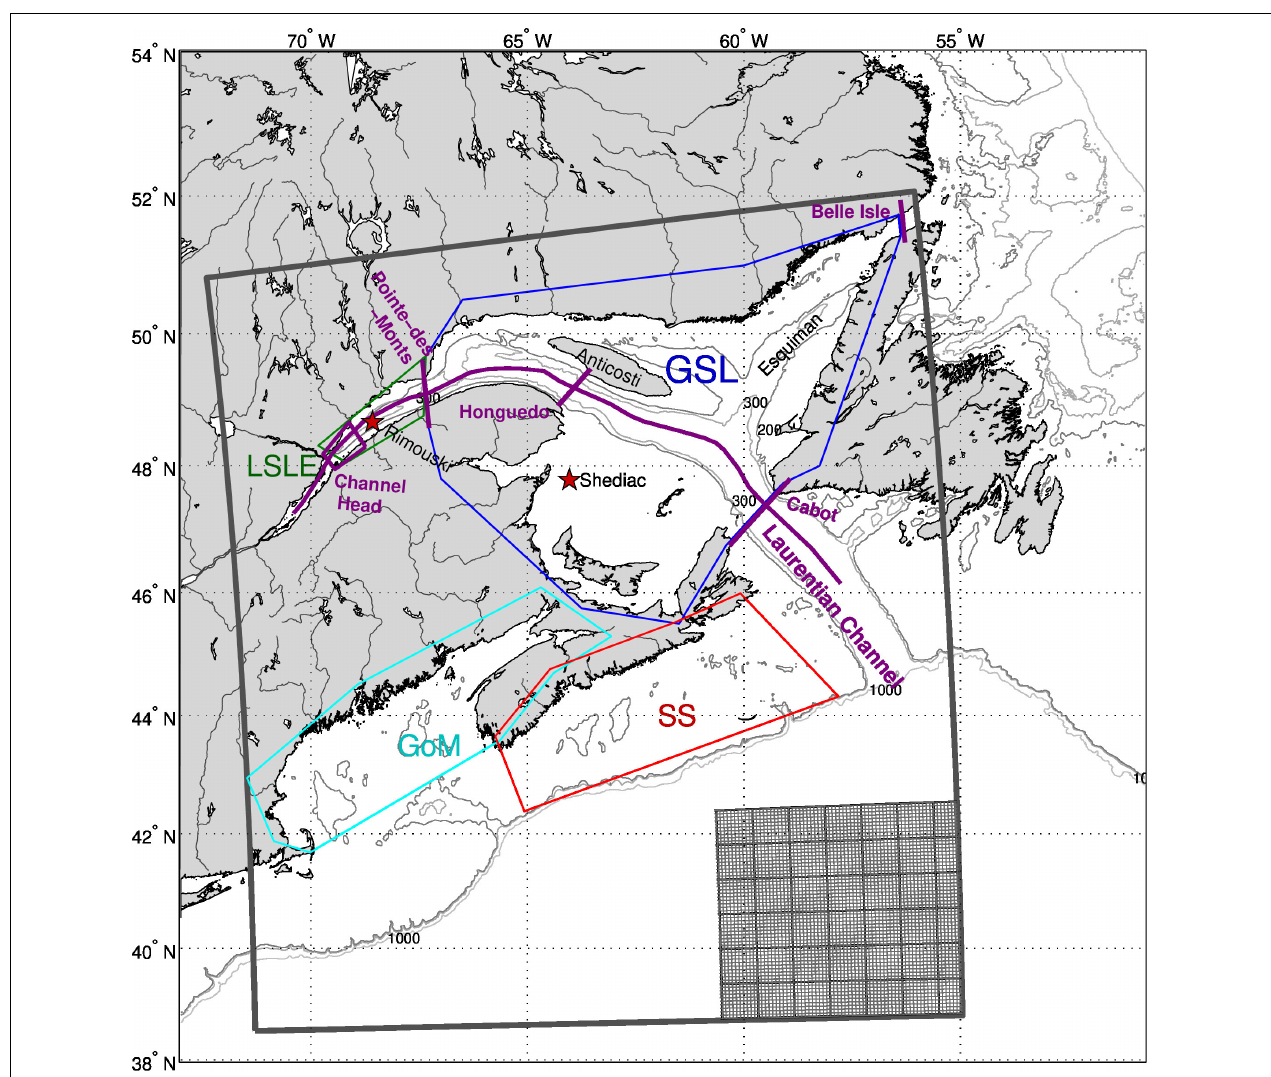
FIGURE 1 | Map of the study area showing the model domain, with a small sub-area showing the grid size in the lower right corner. The 200, 300, and 1000 m depth contours are shown. The purple lines show the position of the transects used in some figures or for transport comparison (Pointe-des-Monts, Honguedo, Cabot Strait, and the Strait of Belle Isle). The line following the Laurentian Channel indicate the positions where data are presented in some figures. The purple box indicate the area over which vertical nitrate fluxes are calculated, while the larger boxes (LSLE in green, GSL in blue, SS in red, and GoM in cyan) represent the regions where average quantities are calculated in some figures. The stars indicate the location of two fixed AZMP stations (Rimouski and Shediac) from which data are used to validate the